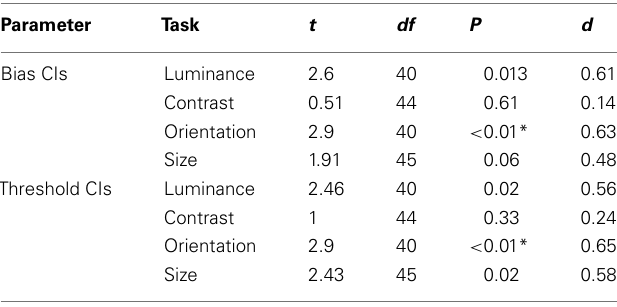
Table 2 | Independent-samples t -tests comparing patient and control group 95% confidence intervals for biases and